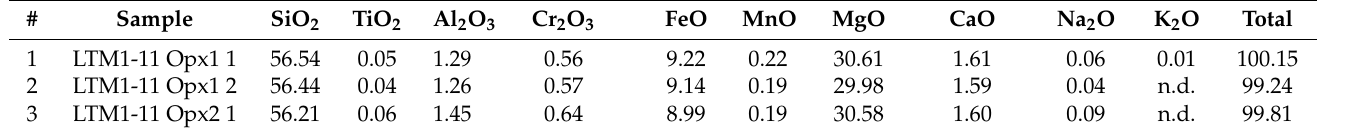
Figure 7. A back-scattered electron image (BSE) displays a specimen of orthopyroxenite (Figure 6a) composed mostly of grains of orthopyroxene (Opx) with the presence of minor quantities of amphi- bole (Amp) and plagioclase (Pl). The location of this sample, Ltm1-11, is shown in Figure 1. Table 1. Compositions of pyroxenes in the orthopyroxenite zone of the Lotmvara-I sill, Kola